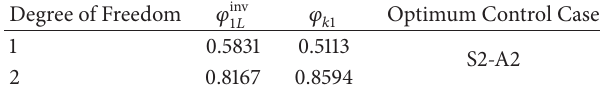
Figure 2: The displacement-time response to the first degree of freedom of 2D system.